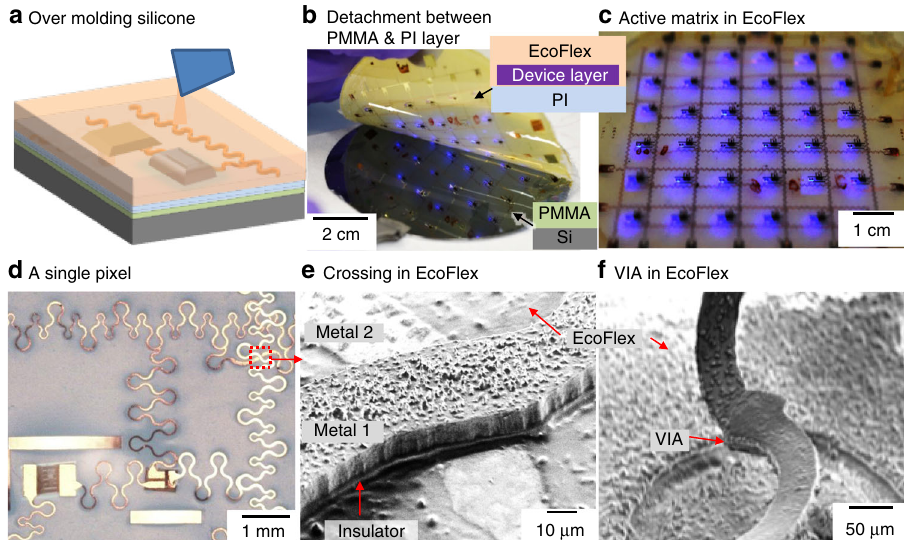
Fig. 2 Second steps to realize integrated stretchable printed circuit boards. Schematic of silicone encapsulation of the device on hard carrier a . A photograph of the detachment process of the device layer from the hard carrier while the device is under operation ( b ) and functionality test of the fi nal device in EcoFlex ( c ). Device in rubber matrix: Photograph of a single pixel of the active matrix encapsulated in EcoFlex showing a transistor and a LED ( d ). SEM image of a crossing of two metal layers in EcoFlex ( e ) and a VIA lifted off from the silicone substrate connecting two metal tracks ( f )